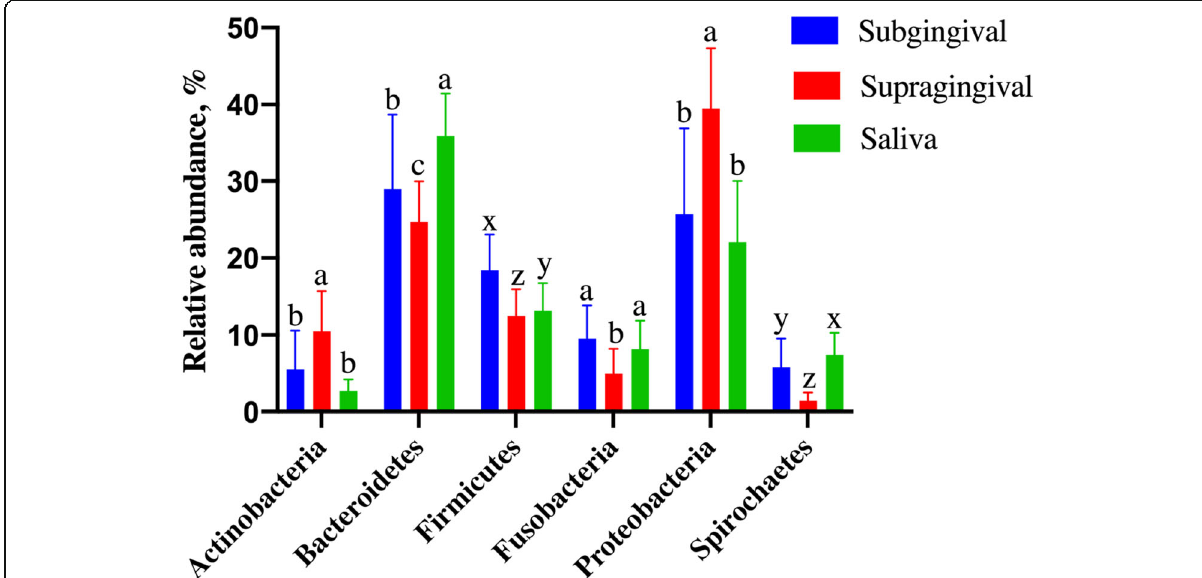
Fig. 3 Predominant oral bacterial phyla (relative abundance, %) present in plaque (supragingival and subgingival plaque) and saliva samples of healthy adult dogs. a-c Means with different superscripts within phyla differ by Tukey's test ( p <0.05). w-z Means with different superscripts within phyla differ by Wilcoxon's test ( p <0.05)